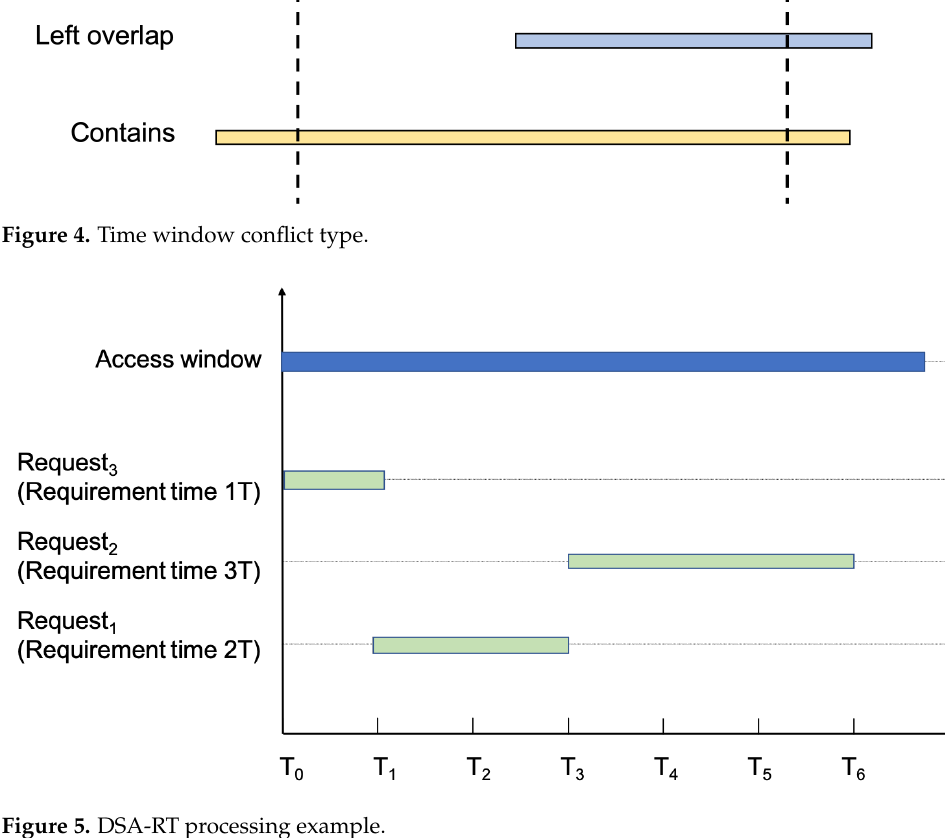
Figure 5. DSA-RT processing